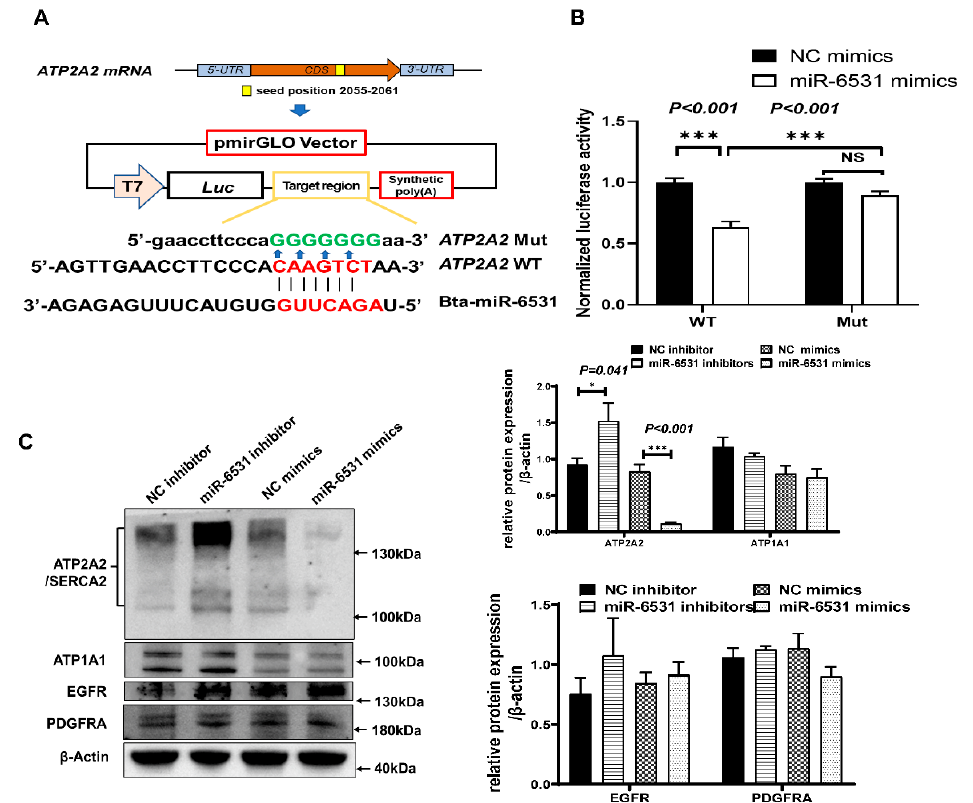
Figure 3. ATP2A2 is a direct target of bta-miR-6531. ( A ) Schematic diagram illustrating the design of luciferase reporters with bta-miR-6531 binding site in wild-type ATP2A2 -CDS region (WT) or mutant ATP2A2 -CDS region (mut). ( B ) The relative luciferase activity was analyzed; ( C ) miR-6531 regulates ATP2A2 protein expression without affecting the protein expression level of other predicted genes ( * p < 0.05, ** * p < 0.001 ).